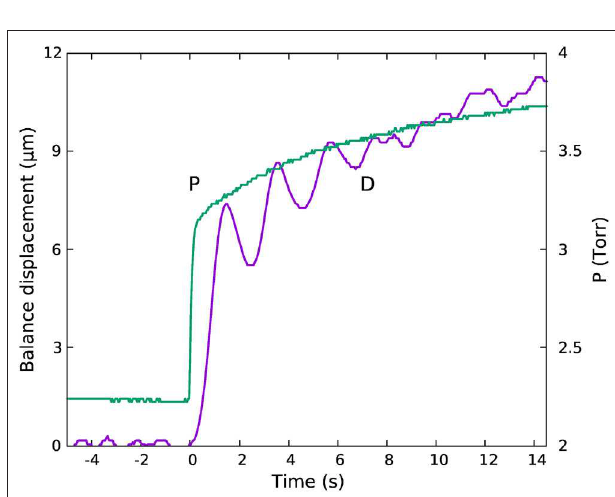
FIGURE 7 | Calculated cold gas thrust F cg (solid purple line), measured thrust F cg (green crosses) in the Wombat chamber ( Figure 3 ) and plenum pressure P plenum (blue stars) measured in the Chi-Kung chamber ( Figure 2 ), vs. argon flow rate.